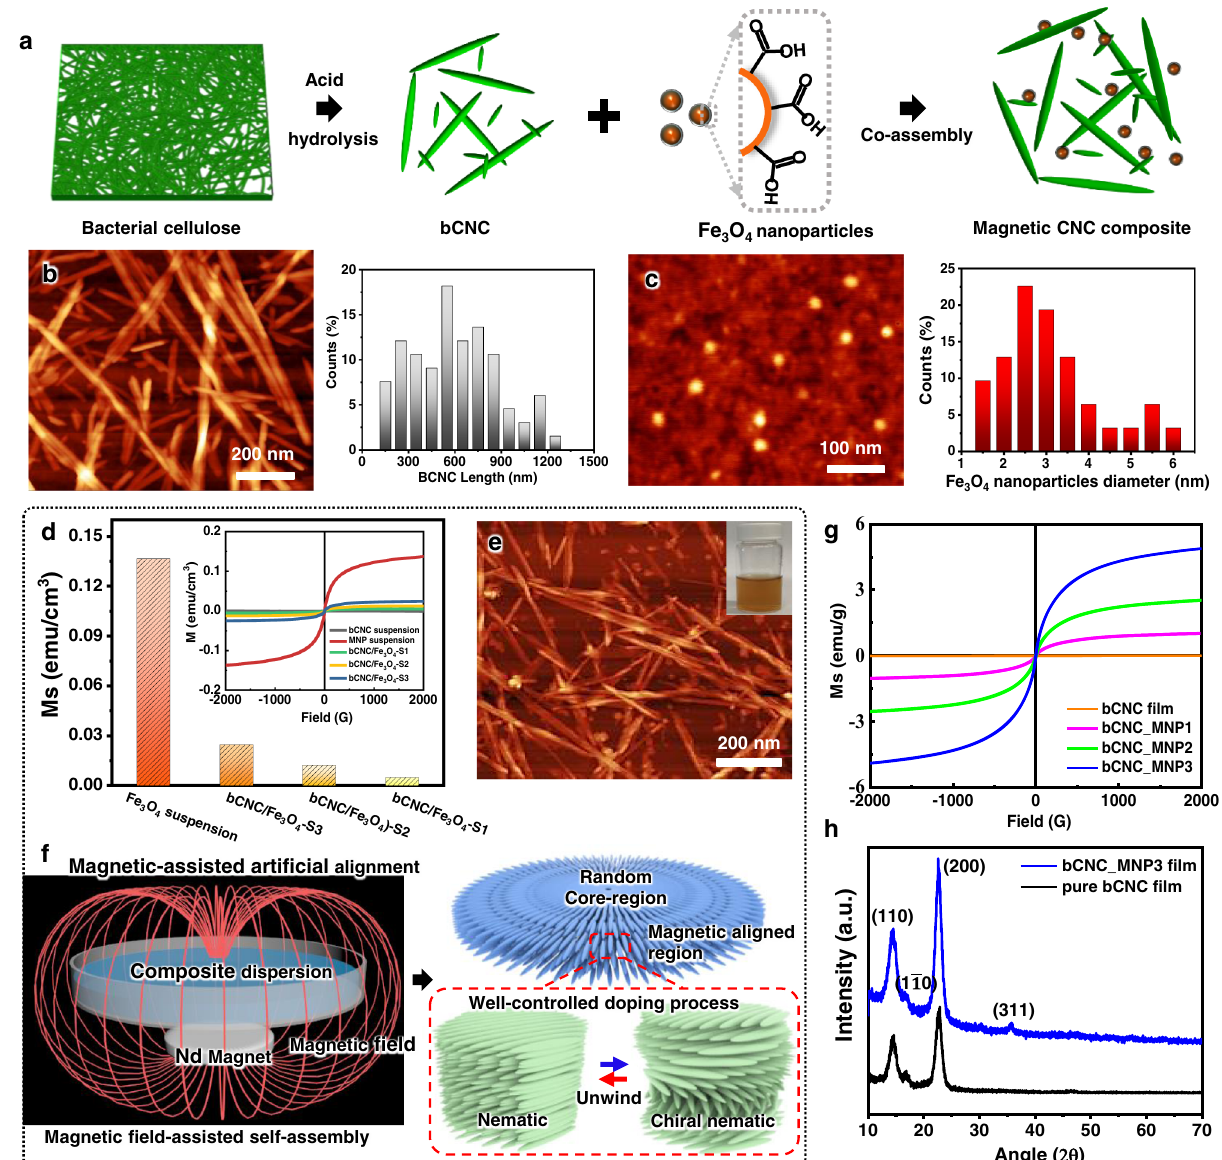
fi lm formation in the presence of a magnetic fi eld (left) and formation of uni- directional nematic ordering that replaces tactoids with chiral nematic organiza- tion (right). A disk-like NdFeB magnet is placed beneath Petri dish during drying, the distance is 1.5cm. g Magnetization curves of bCNC fi lm and magnetic bCNC_MNP1-3 fi lms. h X-ray data for bCNC fi lm and bCNC-MNP3 fi lm with Miller indices for cellulose nanocrystal ordering, (110) and (200) peaks, along with (311) peak for Fe 3 O 4